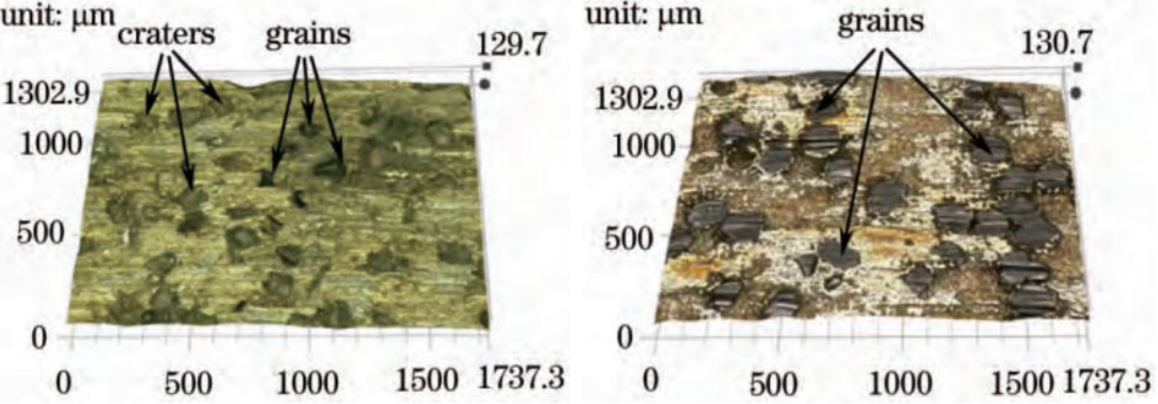
Figure 9. The micro-topography of the grinding wheel surface before and after laser dressing [30].